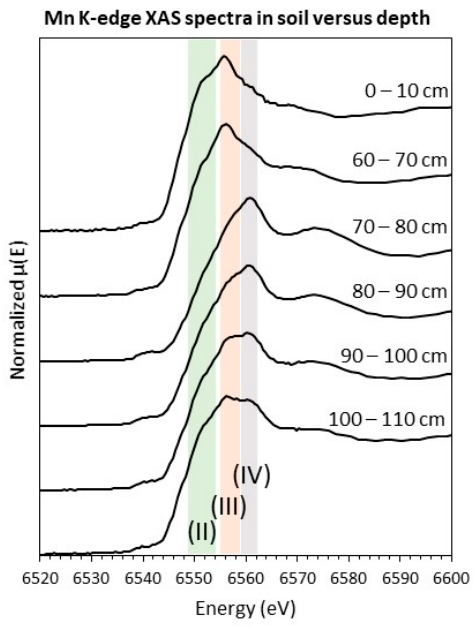
Figure 5. Mn K-edge X-ray absorption near the edge structure spectra collected on powdered soils collected from depths indicated by the labels. Vertical bars show the range in white line energies of single-valance Mn(II) (green), Mn(III) (orange), and Mn(IV) (grey) standard spectra. Soil Syst. 2018 , 2 , x FOR PEER REVIEW 15 of 19 Table 3. Average Mn oxidation state determined by linear combination fits.